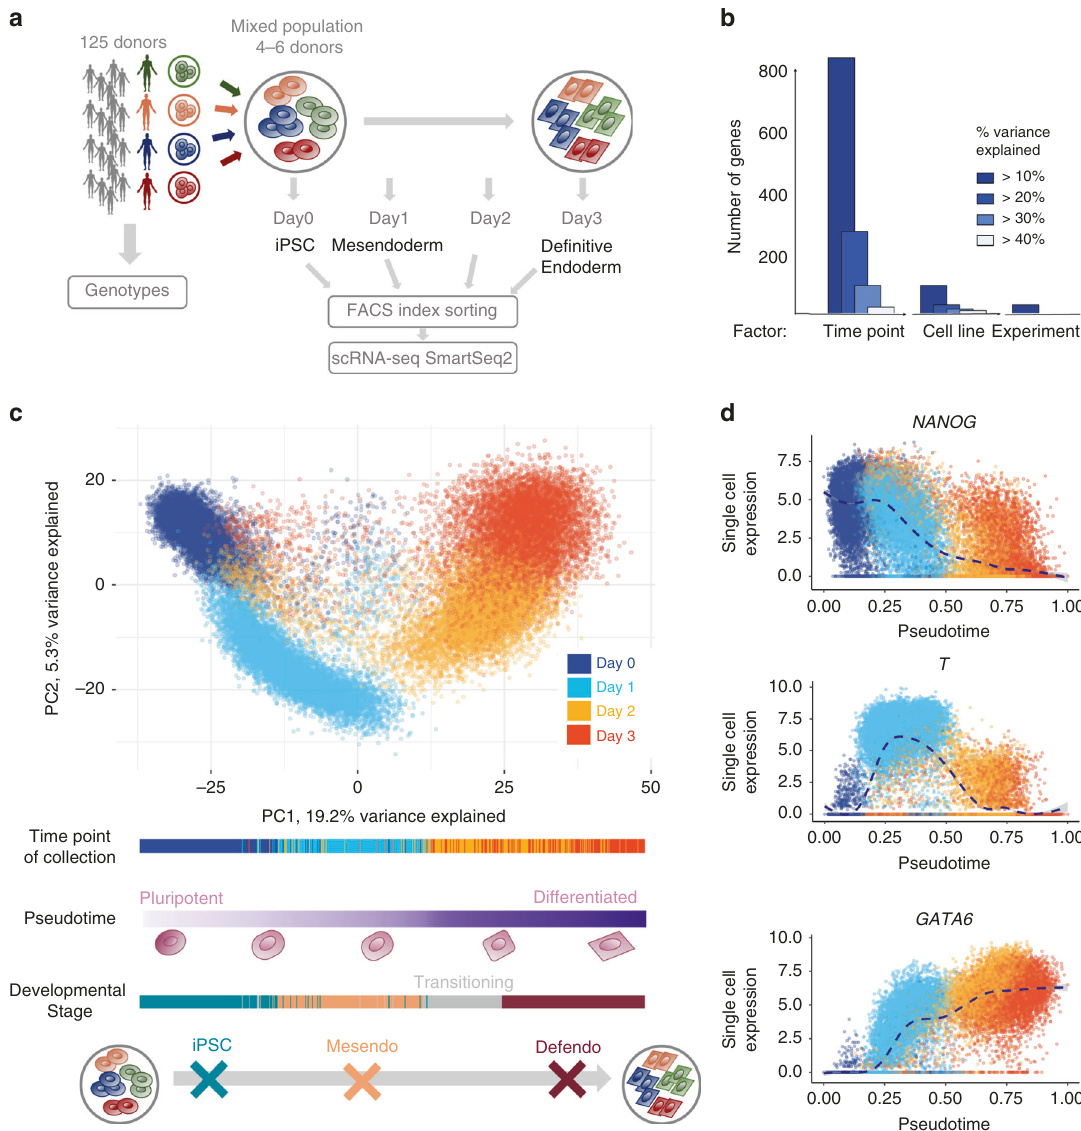
Fig. 1 Single-cell endoderm differentiation of pooled iPSC lines. a Overview of the experimental design. iPSC lines from 125 genotyped donors were pooled in sets of 4-6, across 28 experiments, followed by differentiation towards de fi nitive endoderm. Cells were sampled every 24 h (Methods) and molecularly pro fi led using scRNA-seq and FACS. https://github.com/ebiwd/EBI-Icon-fonts by EBI Web Development is licensed under CC BY 4.0. b Variance component analysis of 4,546 highly variable genes, using a linear mixed model fi t to individual genes to decompose expression variation into time point of collection, cell line and experimental batch (Methods). c Top: Principal component analysis of gene expression pro fi les for 36,044 QC- passing cells. Cells are coloured by the time point of collection. Bottom: Cells are ordered by pseudotime, de fi ned as the fi rst principal component (PC1). From left to right, cells transition from a pluripotent state to de fi nitive endoderm. d Single cell expression ( y -axis) of selected markers for each developmental stage, spanning iPSC ( NANOG ), mesendo ( T ), and defendo ( GATA6 ) stages, plotted along pseudotime ( x